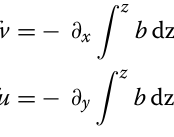
(2) nuity balances: